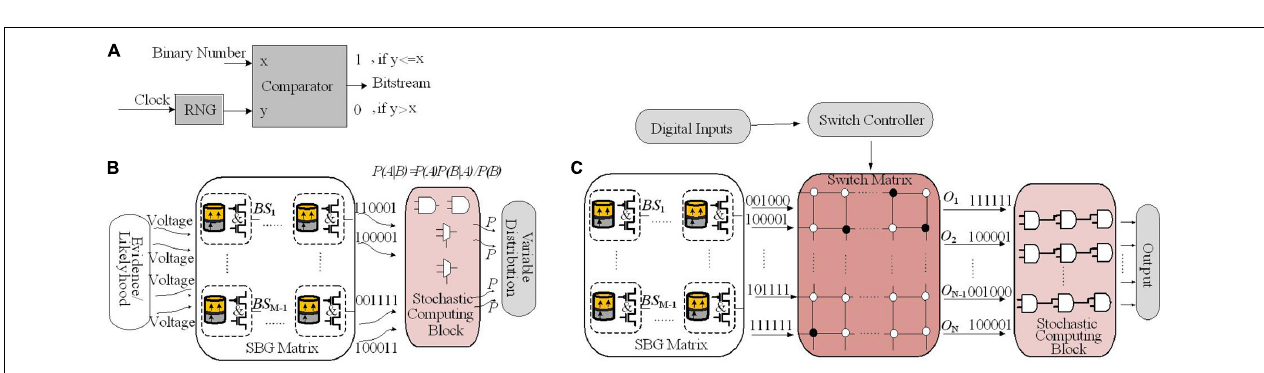
FIGURE 6 | Design flow for structure learning in Bayesian networks. (A) Building blocks of Stochastic Bayesian Nodes (SBN). (B) Every node in a Bayesian network is mapped to an SBN reconfigurable framework. The links of the Bayesian network are implemented with metal routing layers and the connectivity programmed through switch boxes. Stochastic bitstream generator blocks for Bayesian network